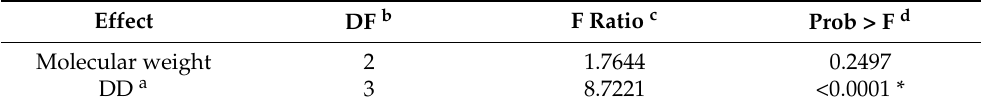
Table 6. One-way ANOVA test results ( α = 0.05) for the effects of DD and molecular weight of the deacetylated chitin samples on the